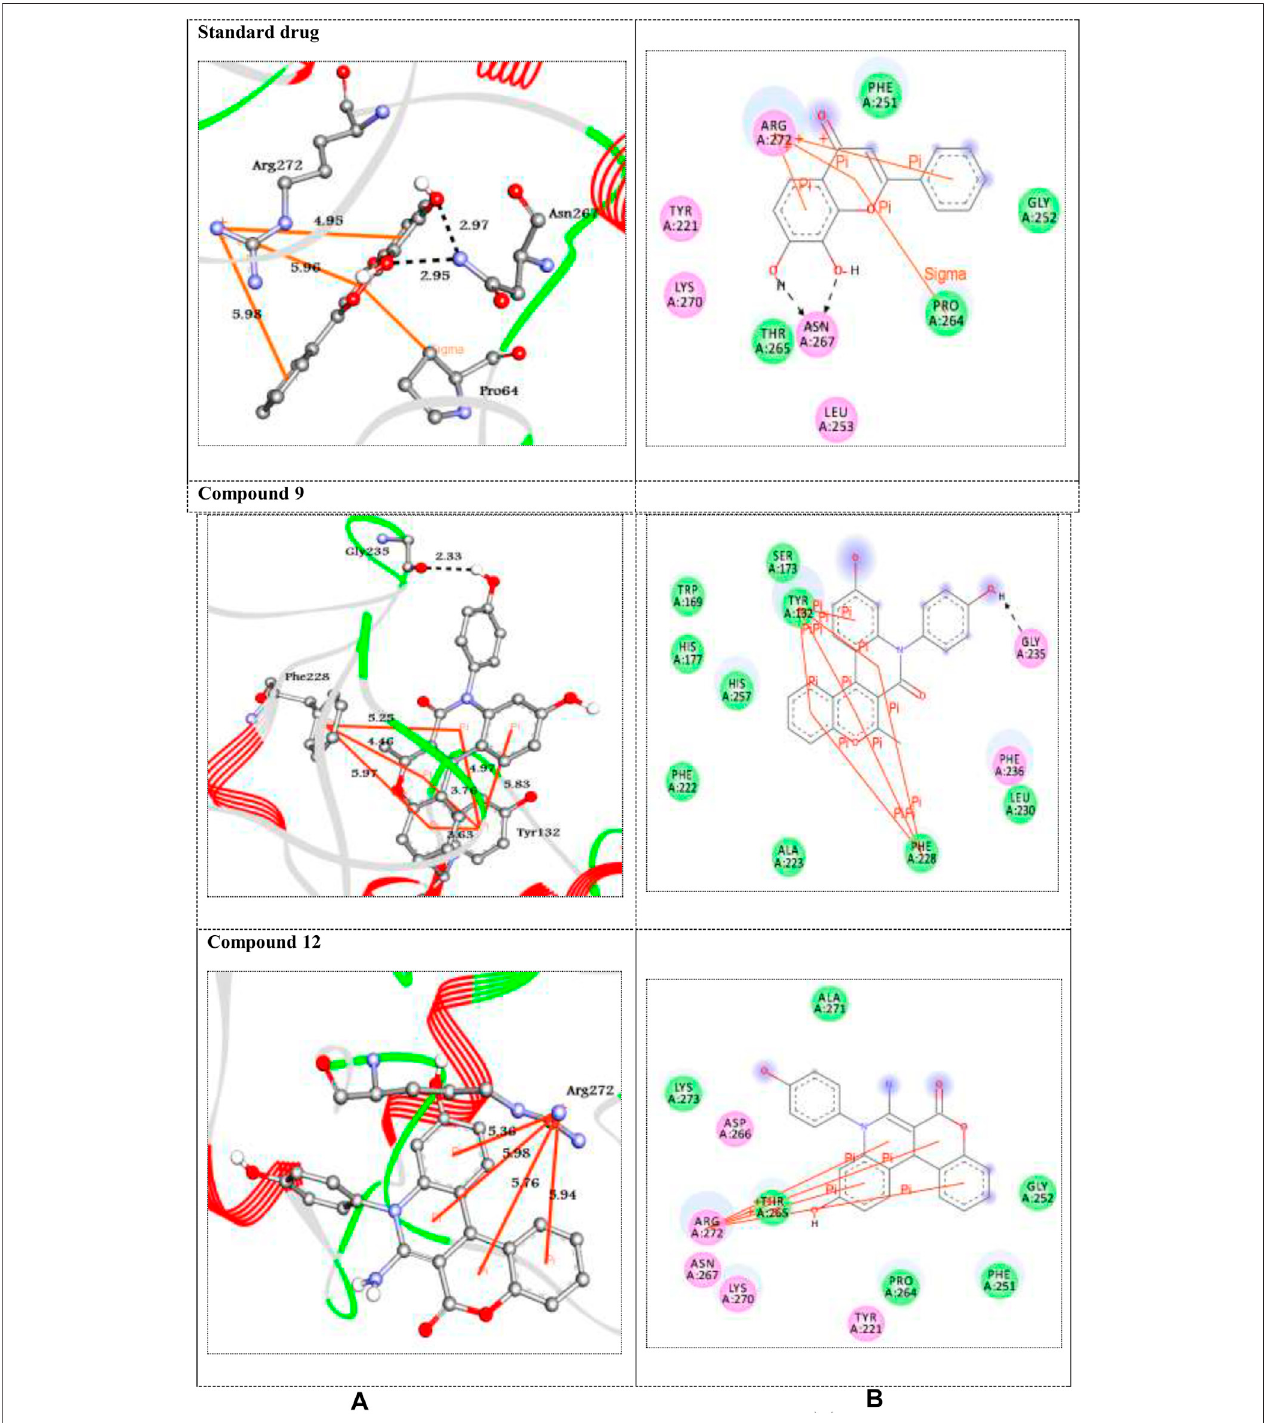
FIGURE1|(A) 3D and (B) 2Drepresentations ofstandarddrugand thebestdockedcompounds with1DXO.H-bondsarerepresented inblackdottedlines while pi-interactions are shown in orange lines. Colored balls with 3-letter code represented the amino acid residues of the target 1DXO.